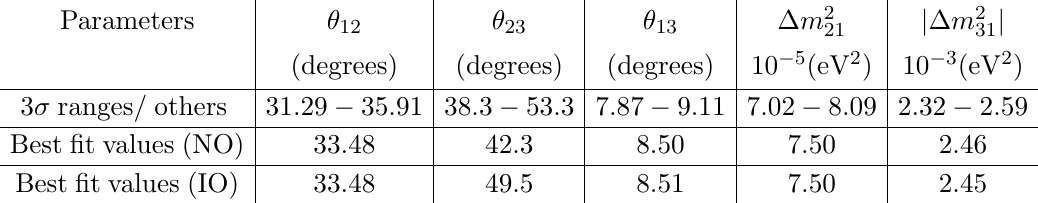
Table 2 . Input values fed into the analysis [86].